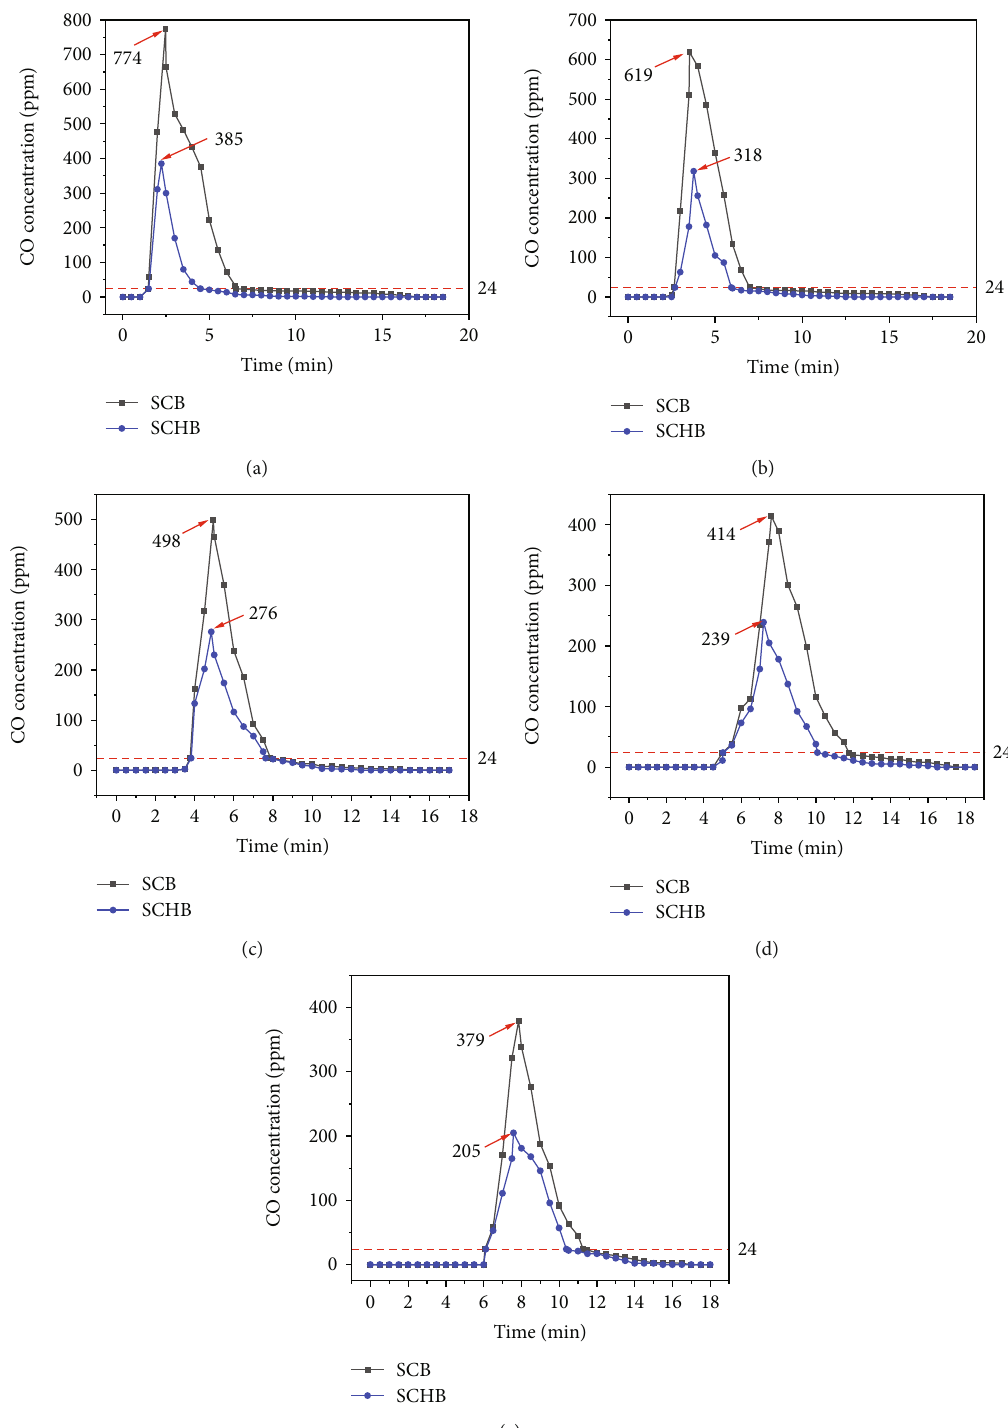
Figure 21: Time-varying curve of CO concentration in six-hole blasting at di ff erent measuring points: (a) 100m from blasting zone, (b) 200m from blasting zone, (c) 300 m from blasting zone, (d) 400m from blasting zone, and (f) 500m from blasting